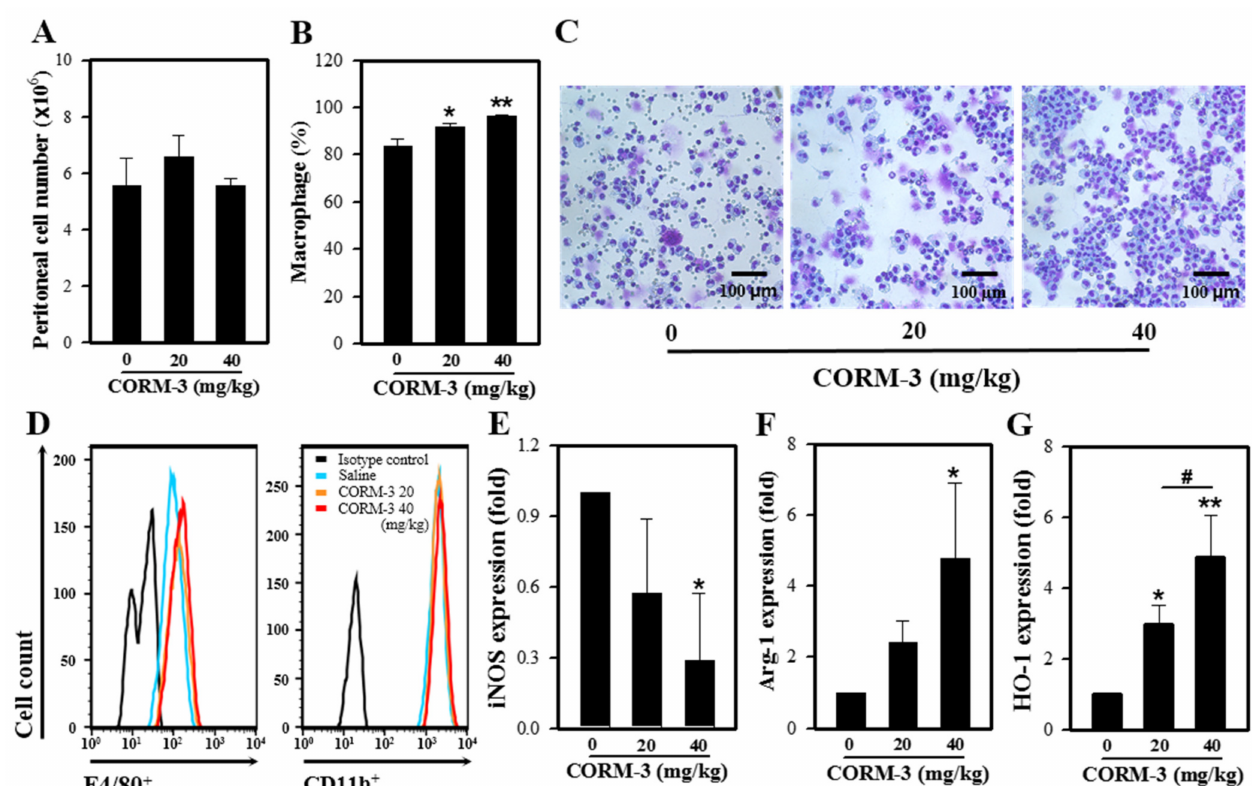
Figure 6. CO enhances M2 polarization in vivo. Mice were injected with 3% thioglycollate followed by CORM-3, and peritoneal exudate cells were collected. ( A ) The number of total peritoneal exudate cells was counted. ( B ) The proportion of macrophages in peritoneal exudates was determined after Diff-Quik staining, and ( C ) the representative images of peritoneal exudate cells. ( D ) Peritoneal exudate cells were stained with antibodies F4/80-FITC and CD11b-PE and analyzed using FACSCalibur. ( E – G ) The mRNA expressions of iNOS, Arg-1, and HO-1 were determined by qRT-PCR. Results are presented as mean ± SD (n = 3); * p < 0.05 and ** p < 0.01 compared to control and # p < 0.05 between groups compared (one-way